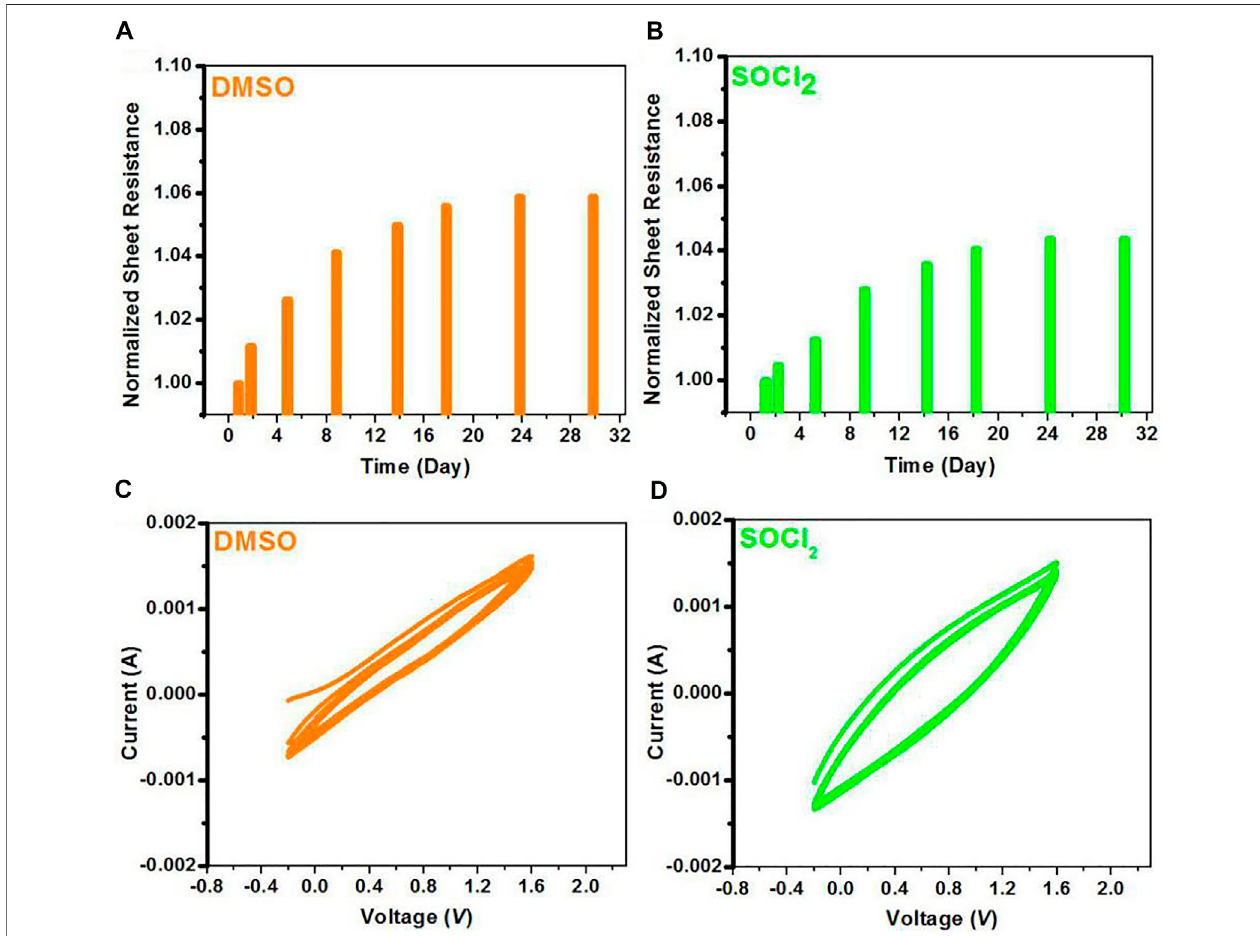
FIGURE4|(A,B) Pro fi lesofnormalized sheetresistanceoftheDMSO-andSOCl 2 -treated PEDOT:PSS fi lmsexposedinambientair. (C,D) CVcurvesofboth fi lms in anhydrous dichloromethane through using 0.1 M Bu 4 NPF 6 as an electrolyte at a scan rate of 100 mV s − 1 .